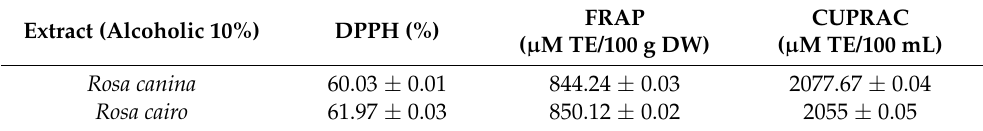
Table 1. Antioxidant capacity of alcoholic extracts.